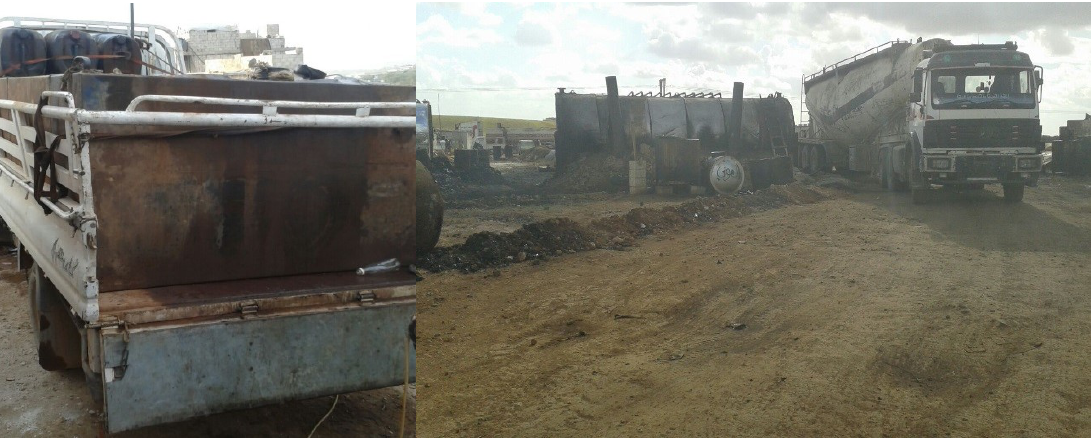
Figure 8. Tanker trucks for transport to fuel stations and customers.